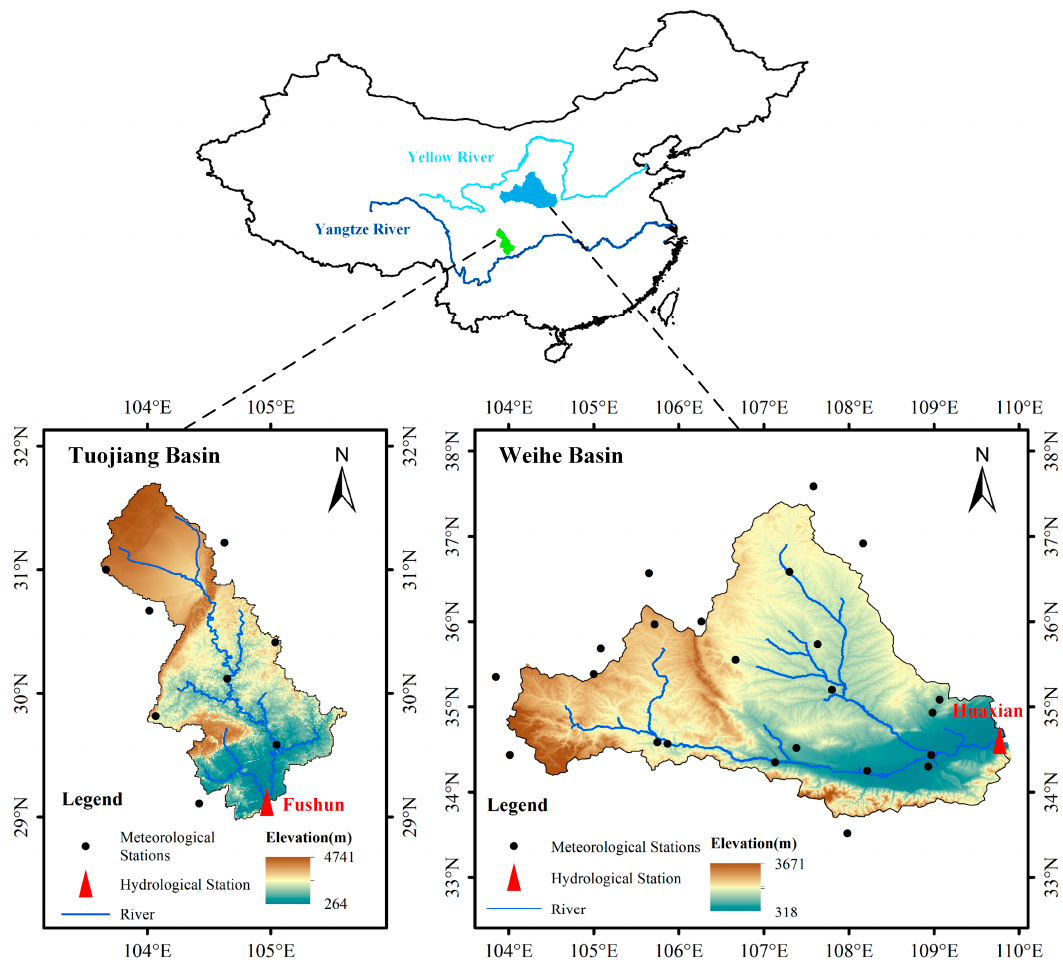
Figure 2. Location of Weihe Basin and Tuojiang Basin in China and the meteorological and hydrological gauges.